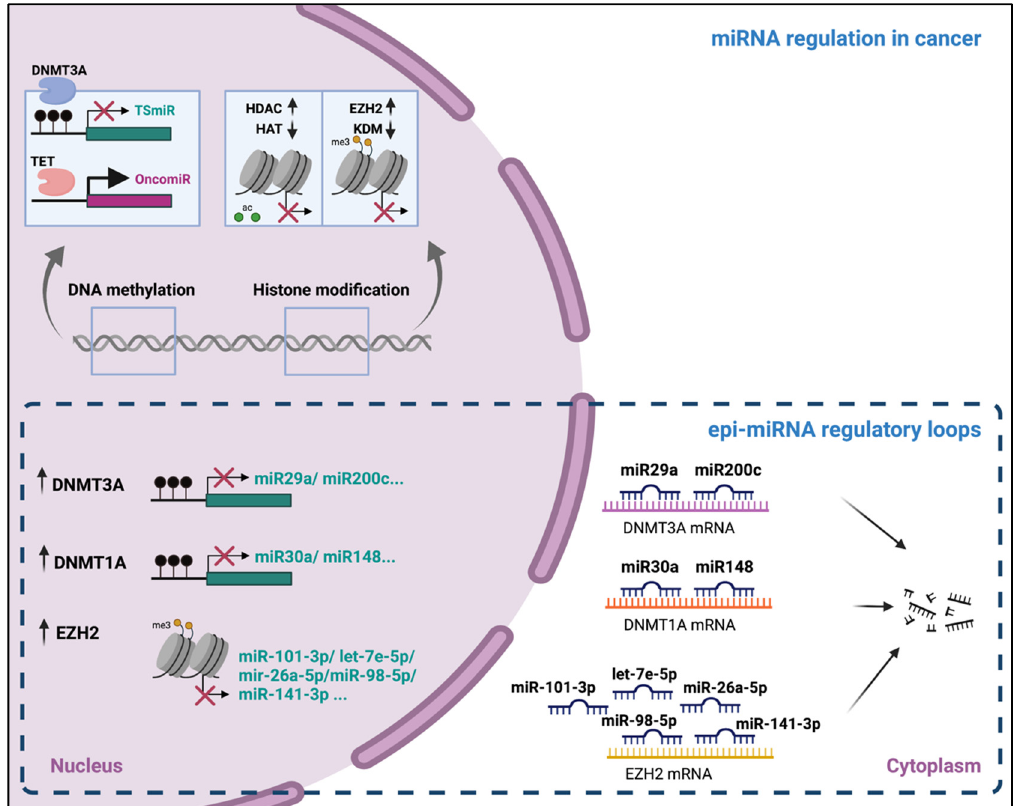
Figure 2. The regulation of microRNAs and epi-miRNAs in cancer. DNA methylation and histone modifications are the major epigenetic mechanisms involved in the regulation of miRNA expression. Many epi-miRNAs have been shown to target epigenetic factors, such as DNMT3A, DNMT1A, and EZH2, and these, in turn, are implicated in the reciprocal regulation of the epi-miRNAs, giving rise to regulatory loops that are often dysregulated in cancer. Created with Biorender.com.